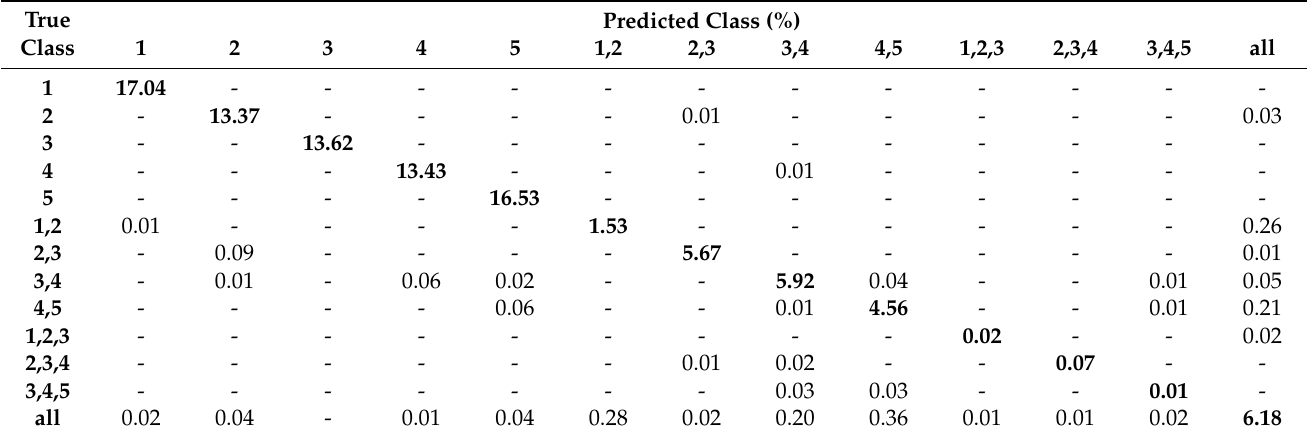
Table 5. Confusion matrix related to damaged compartments evaluated at 250 s. Training: MC20; validation: MC50b.